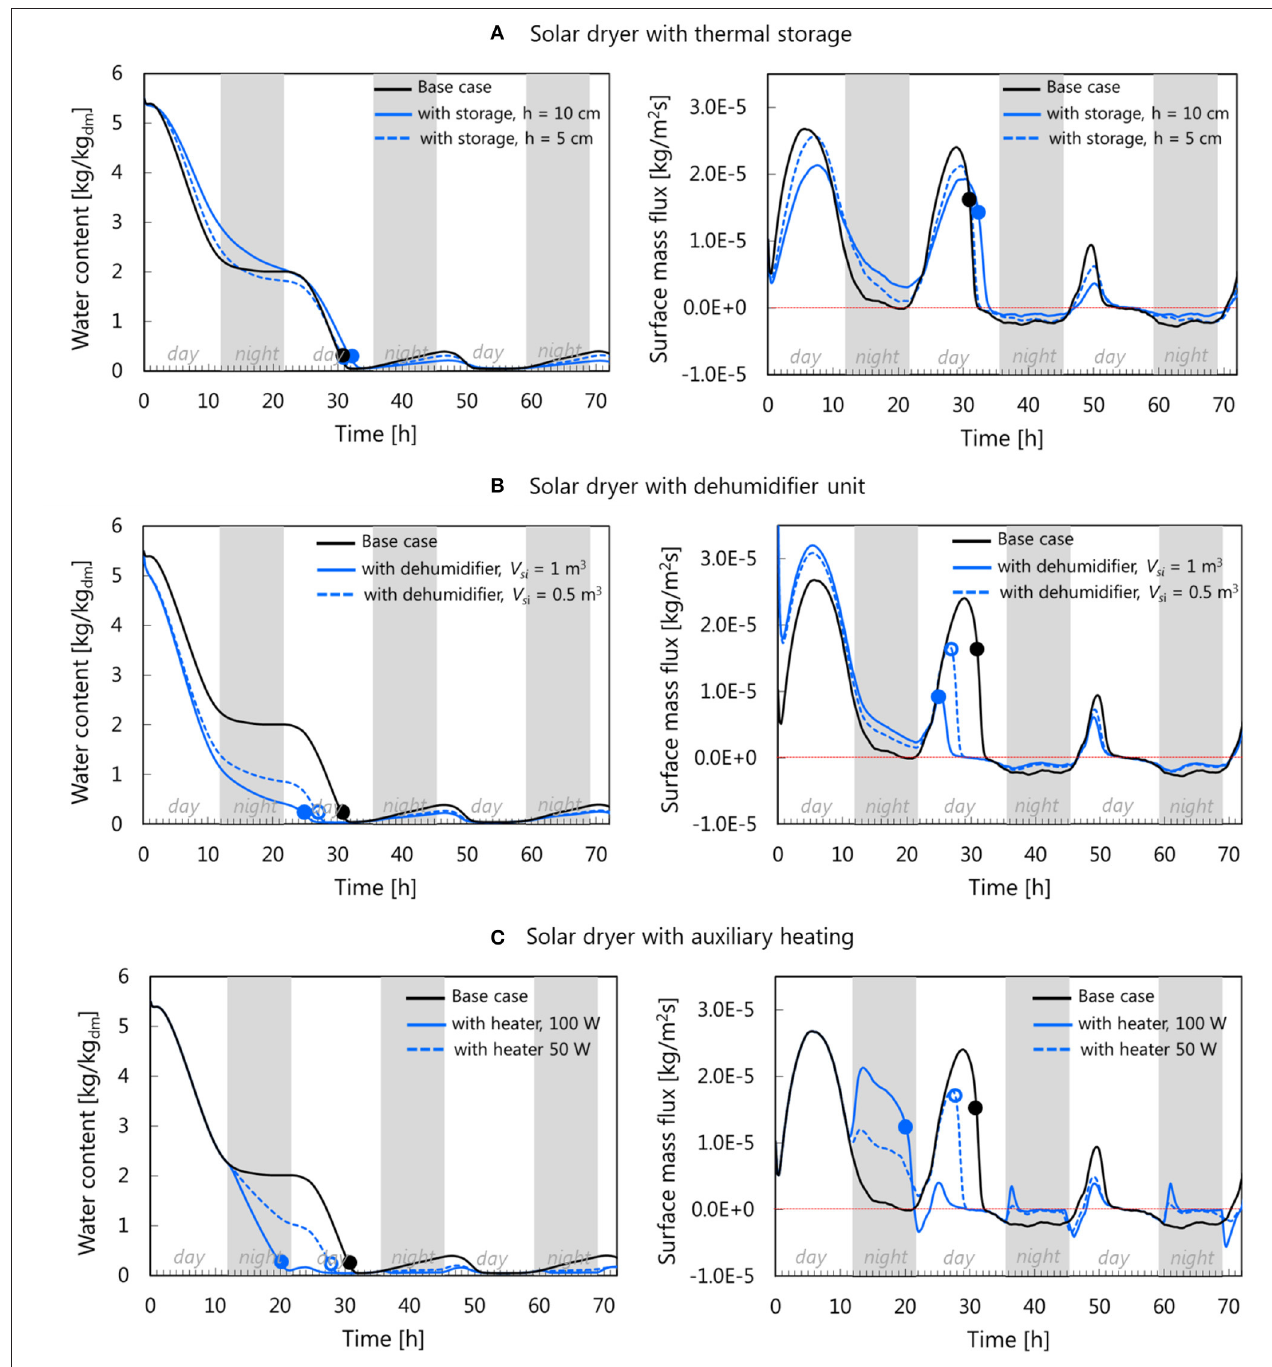
FIGURE 10 | Comparison of water loss and drying rate between the solar drying in base case configuration and solar dryer equipped with (A) thermal storage, (B) dehumidifier unit, and (C) auxiliary heating. The dots represent the water content and surface mass flux at the end of the drying time.